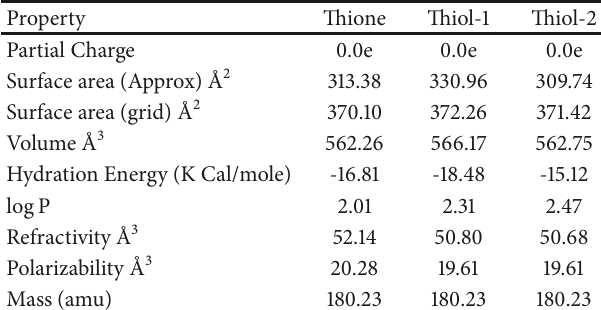
Table 3: QSAR properties of